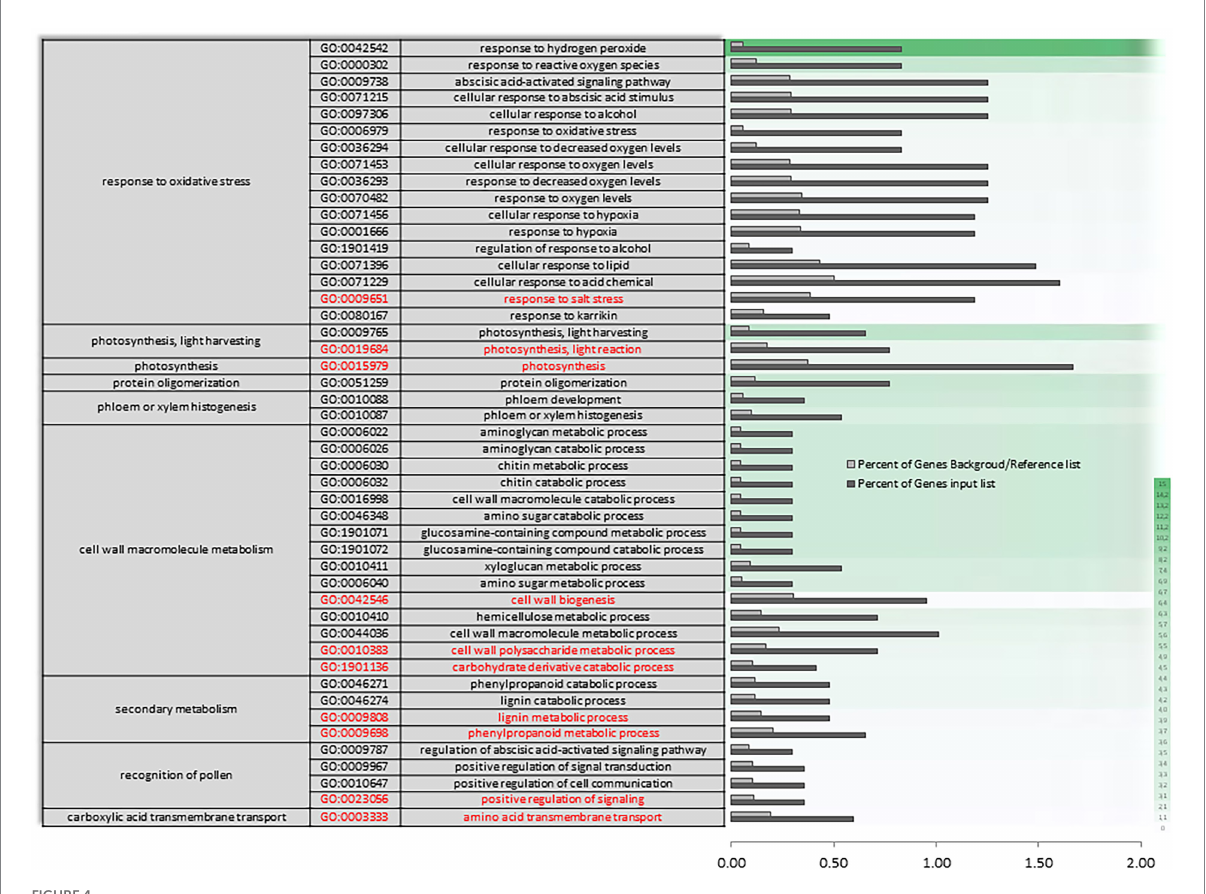
FIGURE 4 Specific gene ontology enrichment. DEGs obtained between after harvest (AH) and non-cold stored (NCS). Bar chart showing in detail the most significant biological processes terms overrepresented obtaining by a Singular Enrichment Analysis (SEA; FDR ≤ 0.05) in AH vs. NCS comparison. The Y-axis shows the definition of GO terms. The X -axis is the percentage of genes mapped by the term, and represents the abundance of the GO term. The percentage for the input list is calculated by the number of genes mapped to the GO term divided by the number of all genes in the input list. The same calculation was applied to the reference list to generate its percentage. These two bars are classificated by a color key showing a green gradient scale for the frequency between both percentages